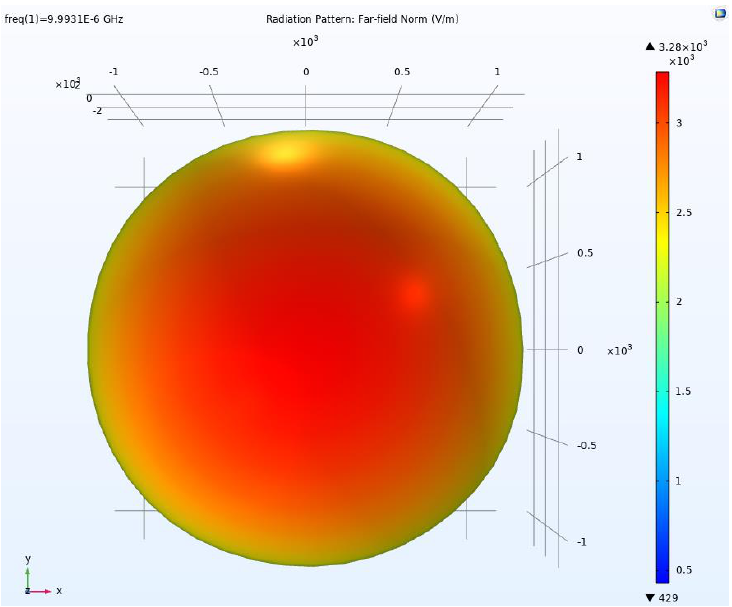
Figure 12. Pattern shape seen from the direction of electromagnetic wave propagation.